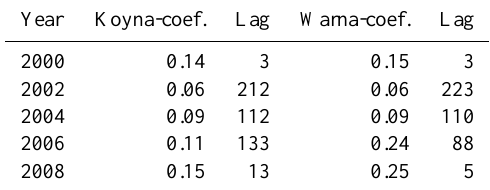
Fig. 5. Cross correlation between Koyna reservoir water level and the seismicity of the region for (a) 1997 (b) 2001 (c) 2004 and (d) 2006. Table 1. The correlation coefficient, time lag (for Koyna reservoir and Warna reservoir with the seismicity of the region). Year Koyna-coef. Lag